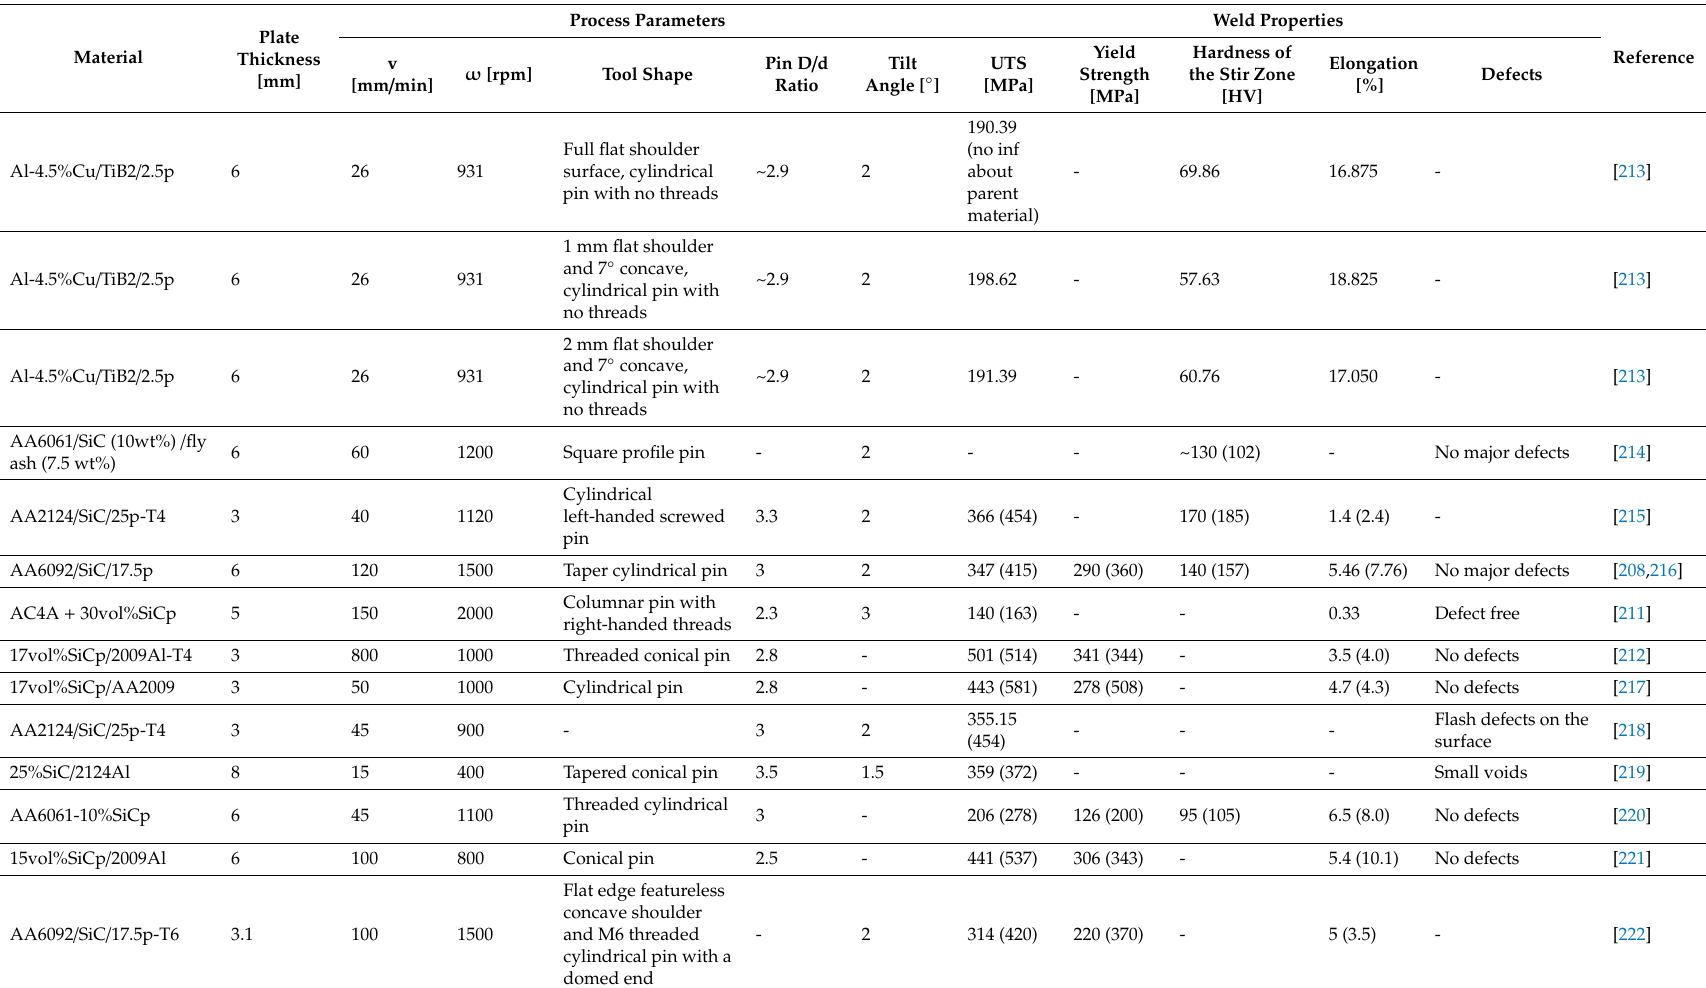
Table 7. FSW of composites—process parameters and mechanical properties of the